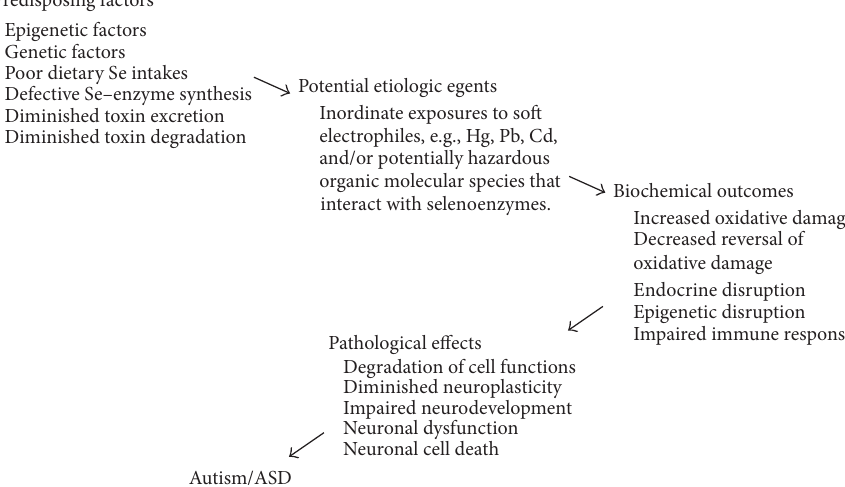
Figure 3: Depiction of potential etiologic contributors to disruptions of selenoenzyme physiology that may lead to disruptions of redox control and pathological consequences of autism and ASD. The factors and agents depicted are not all necessarily involved, but increases in predisposing factors along with additive contributions of increased exposures to thio- and selenoreactive electrophiles would be expected to increase the likelihood of progression to